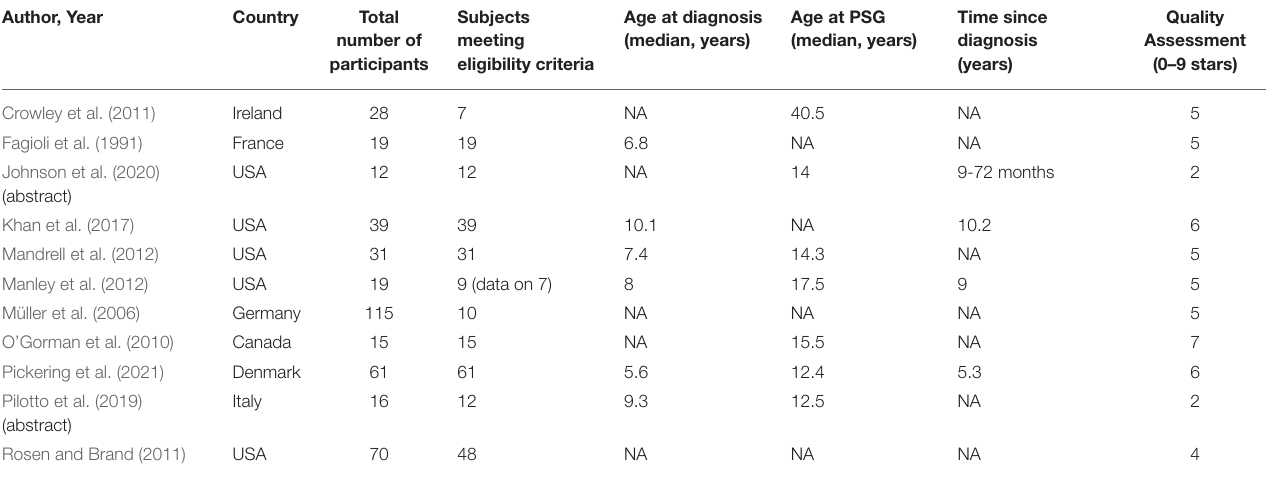
TABLE 1 | Characteristics of studies according to country, number of participants, age at diagnosis, age at polysomnography, and quality assessment following the Newcastle-Ottawa Scale. Author,